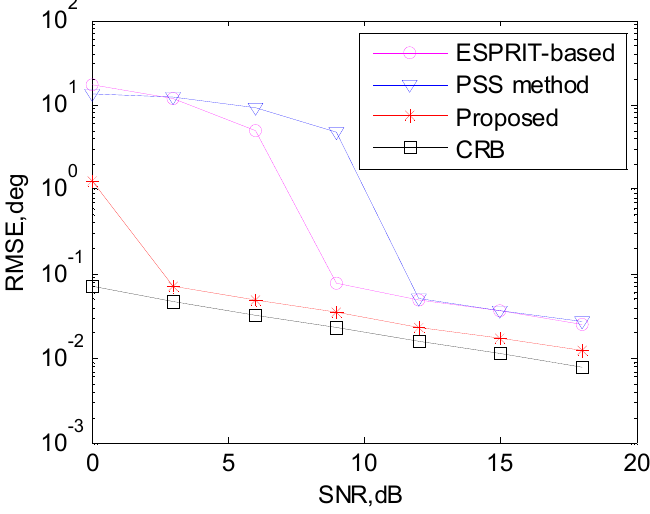
Figure 7. DOA estimation performance comparison with three sources.